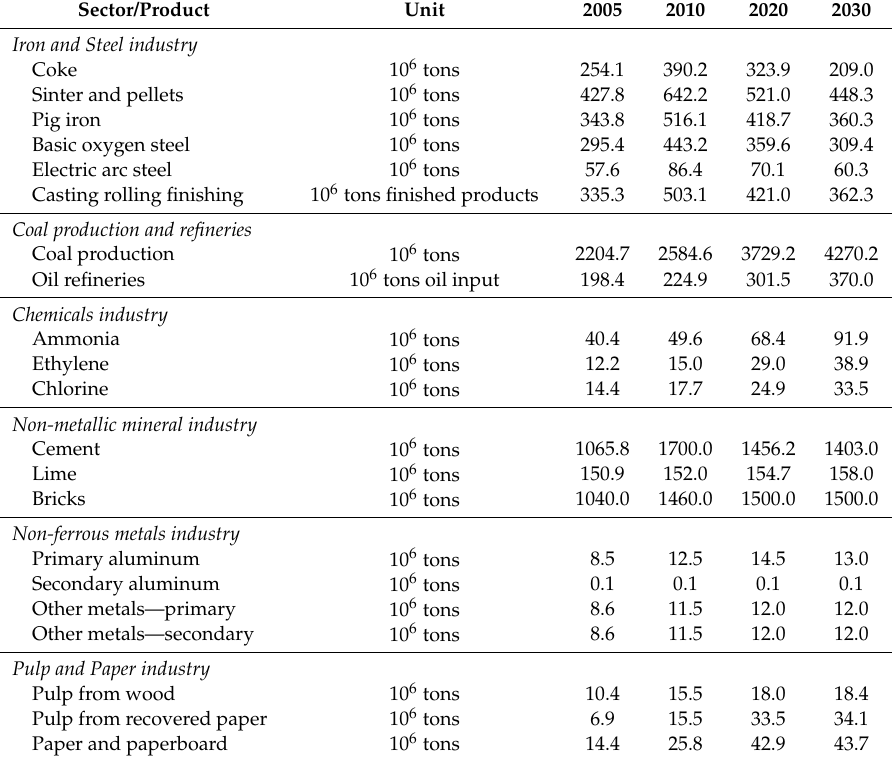
Table A1. Statistical data and projection of production volumes of the industrial products modeled here for the case of China. Source: [52] and